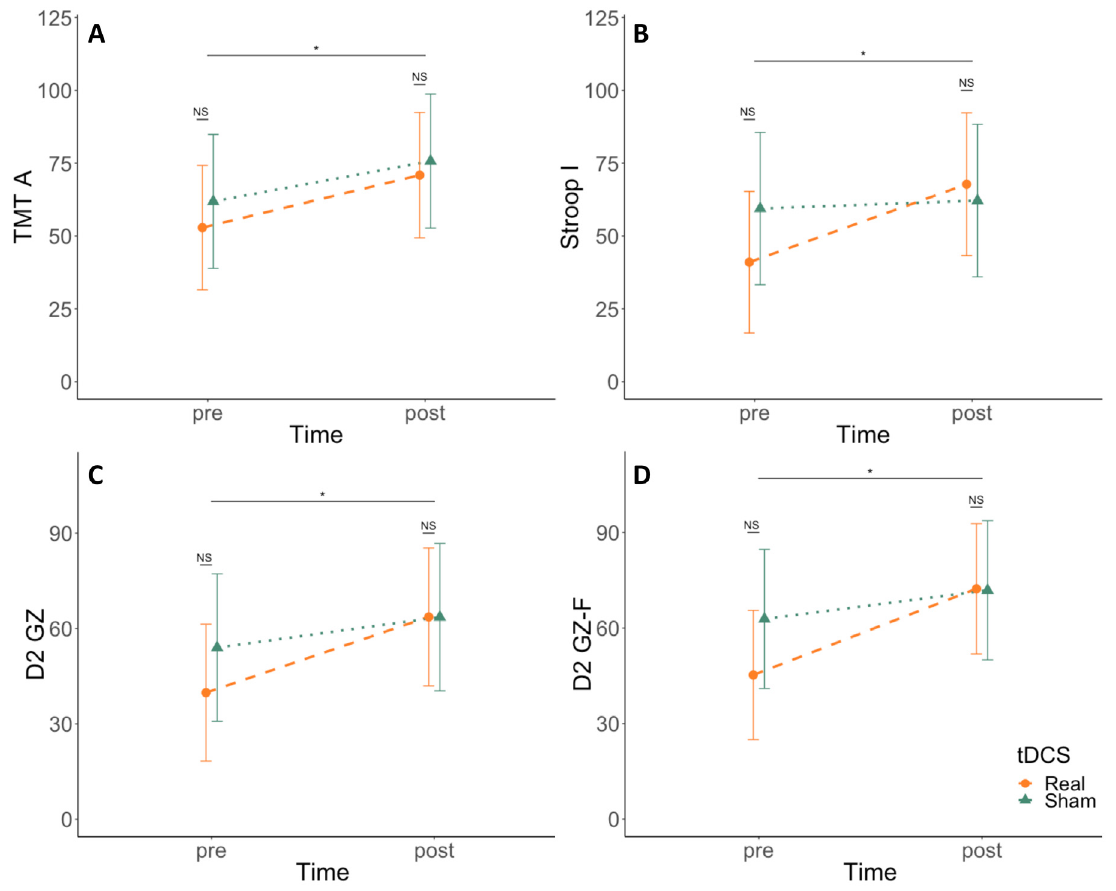
Figure 7. Mean pre- and postscores for updating and control on the A. Trail Making Test (TMT) part A, B. Stroop-Color Word test Card I, C. D2 G score, and D. D2 G – F score for the sham (dotted, triangles) and real (dashed, circles) group with 95% confidence intervals. Continuous z z lines indicate main effects, dashed and dotted lines indicate a significant difference between the pre- and postscores of the separate group (real: dashed; sham: dotted) as found by the post-hoc analyses. NS = non-significant; * = p ≤ 0.05; ** = p ≤ 0.01.